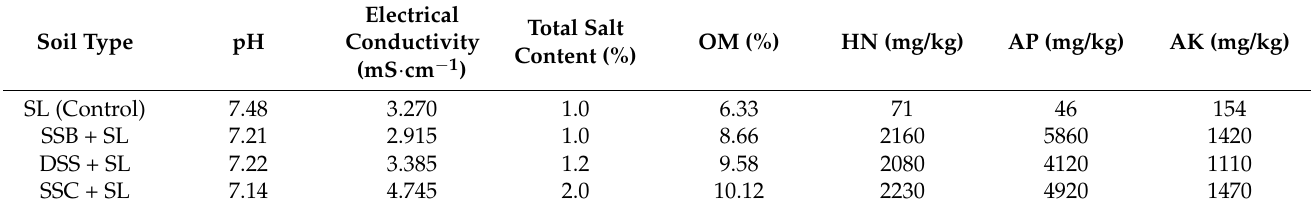
Table 3. Chemical properties of virgin SL and soil modified with three sewage sludge